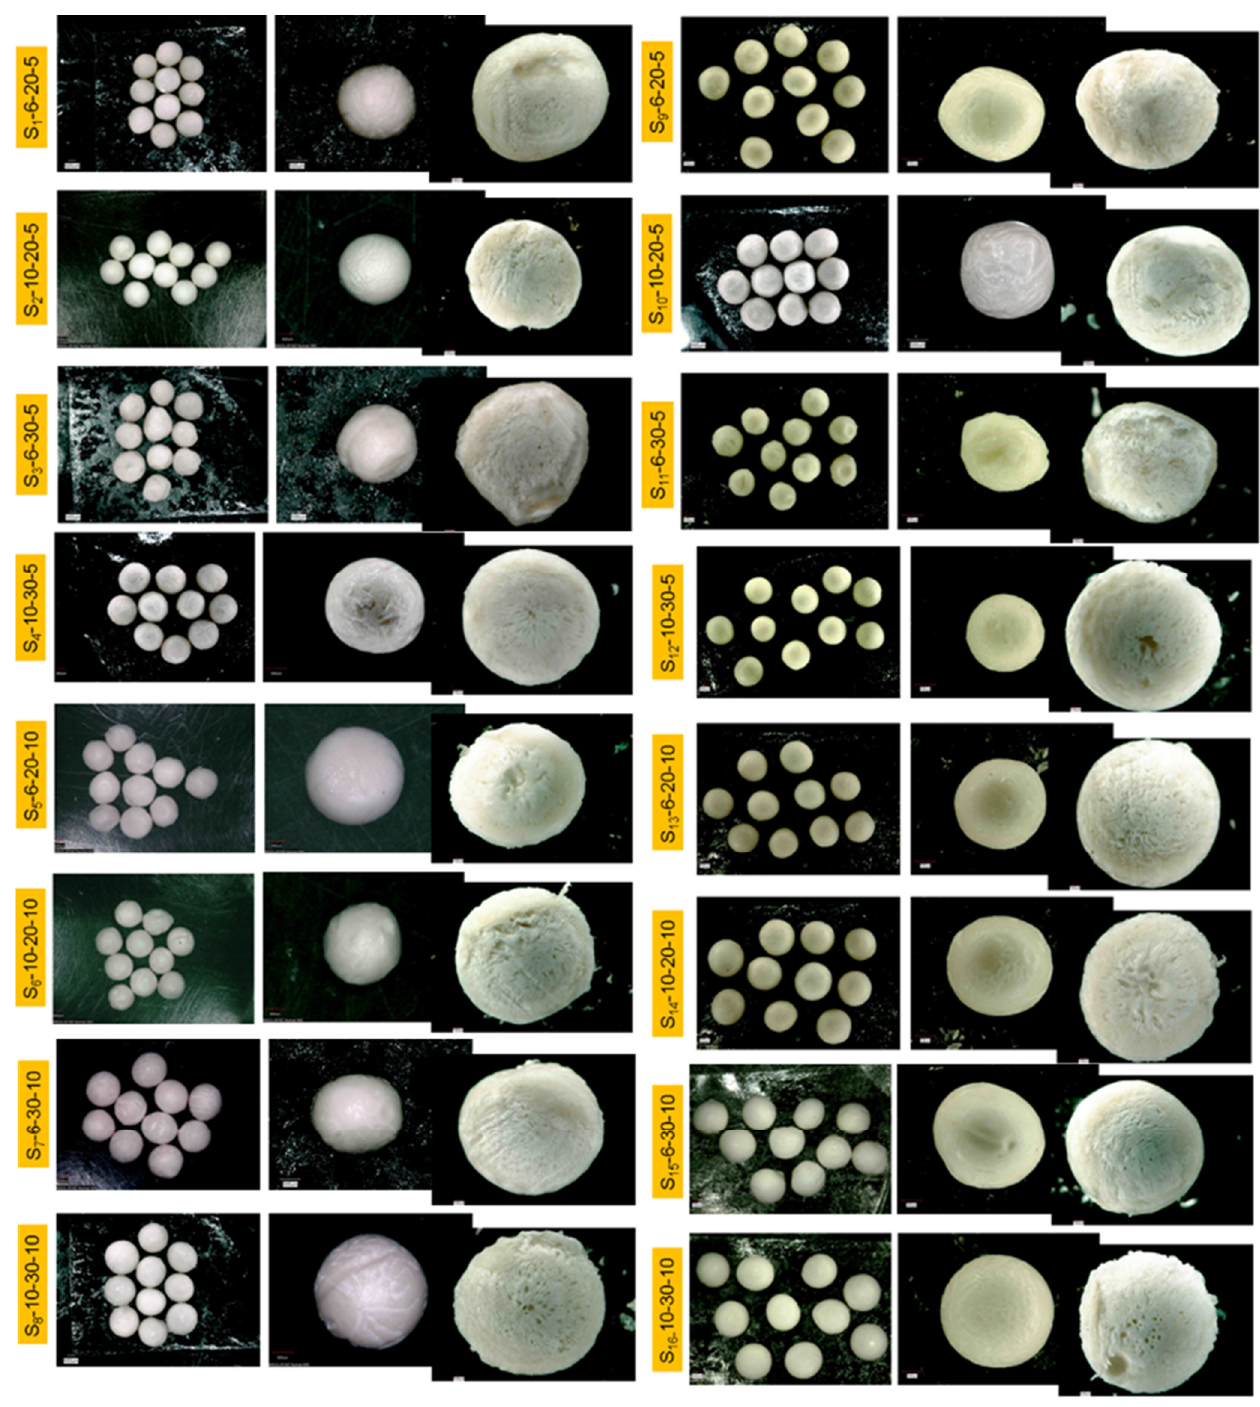
Figure 4. Images obtained by optical microscopy with magnifications of 20×, 60×, and 100× for all spheres of experimental design.